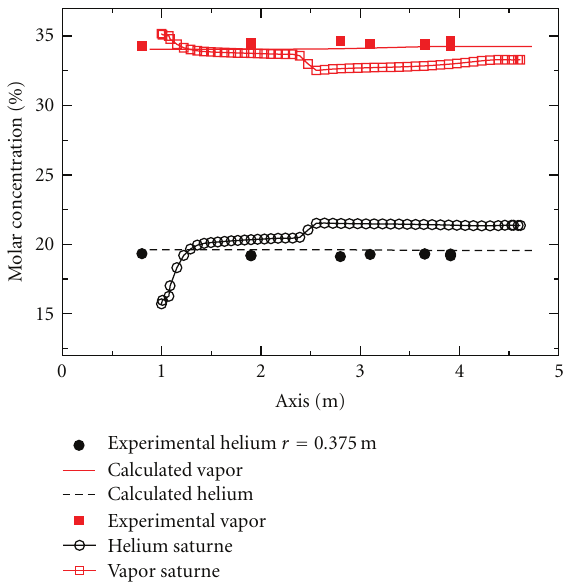
Figure 18: Vertical profile of the helium and vapor molar concen- tration at r = 0 . 375 m: steady state